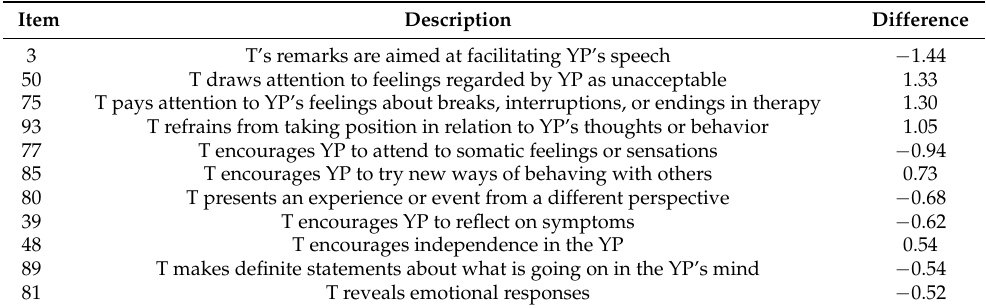
Table 4. Interaction structure differences measured in Z-scores on APQ items describing therapist (T) actions.